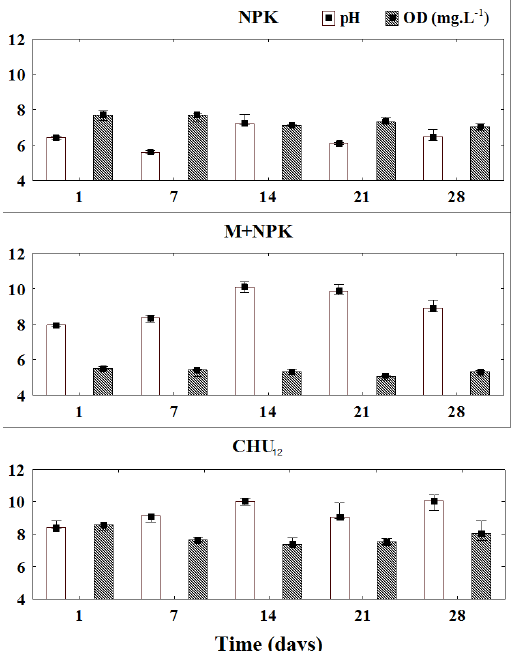
Figure 3. Weekly variations of total phosphorus (TP) Figure 2. Weekly variations of pH and dissolved oxygen and total ammonia nitrogen (TAN) of culture media parameters from three different media: inorganic fertilizer (DO) of culture media parameters from three different (NPK), macrophyte with inorganic fertilizer (M+NPK) media: inorganic fertilizer (NPK), macrophyte with in- and commercial (CHU ). Data represent mean ± SD organic fertilizer (M+NPK) and commercial (CHU ). 12 12 of three replicates per medium (NPK, M+NPK and Data represent mean ± SD of three replicates per medium CHU (NPK, M+NPK and CHU ). 12 12